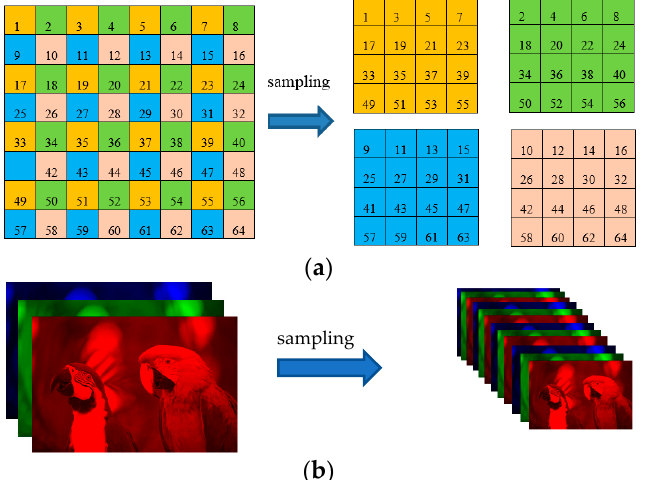
Figure 2. A simple demonstration of the sampling method. ( a ) An image is sampled to obtain four sub-images; (b) A three-channel RGB image is sampled to form four three-channel sub-images. According to the prior knowledge of image local similarity, the four sub-images are similar, so they are composed of a sub-image tensor which has a low-rank structure. It should be noted that if the pixels of the image rows and columns are not even, we can add one row or one column and then do the down-sampling processing. It can be seen that the tensor representation of the color image kodim23 is A ∈ R 512 × 768 × 3 in Figure 1. After sampling, we get the sub-image set denoted by A s ∈ R 256 × 384 × 12 . Here we give the singular values of the tensor bcirc ( A s ) as shown in Figure 1d. Compared with Figure 1c, it can be seen that most of the singular values of the corresponding tensor of the sub-image set appear to be smaller. Therefore, compared with the original whole image, the sub-image data has stronger property of low